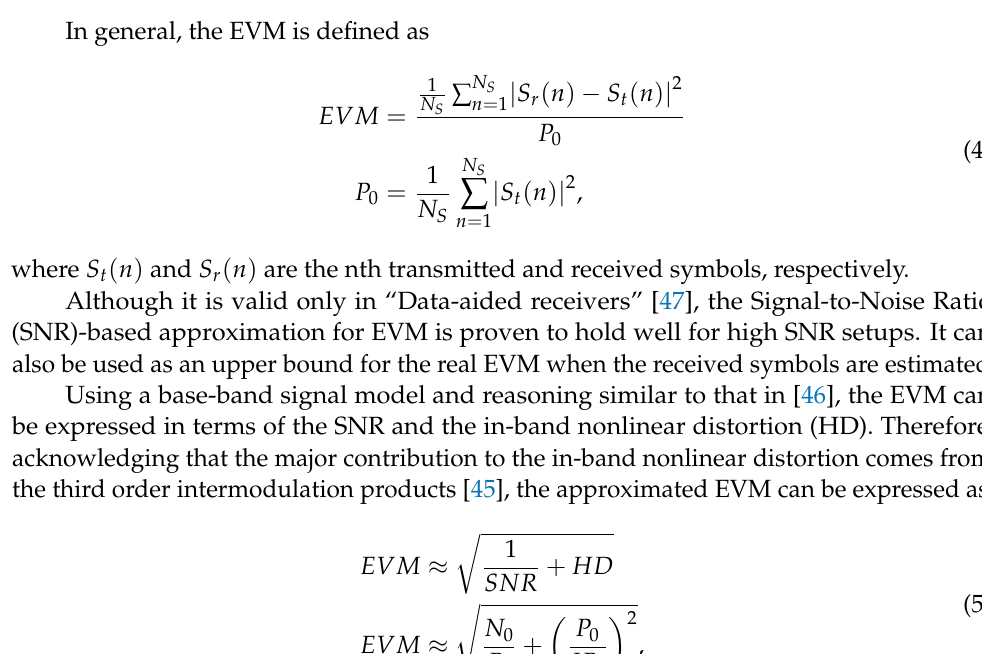
Figure 8. Harmonic components generated by the test reconfigurable antenna, with indication of IP 3 . ( left ) M 1 , ( right ) M 4